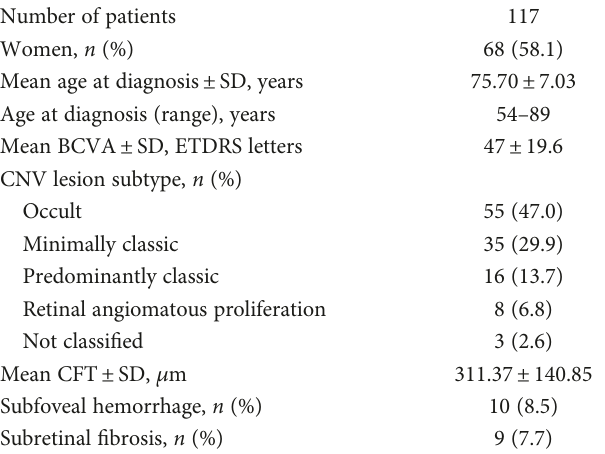
Table 1: Baseline characteristics of the patients. Table 2: Follow-up characteristics of the